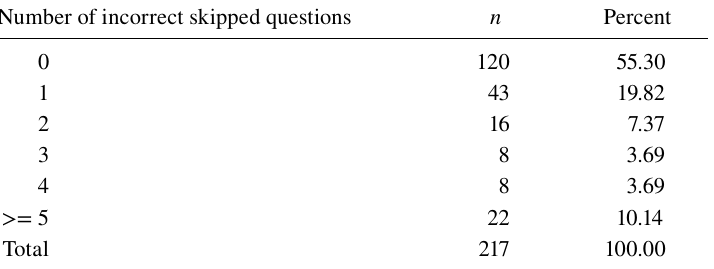
Interviewer behavior regarding incorrect skipping of